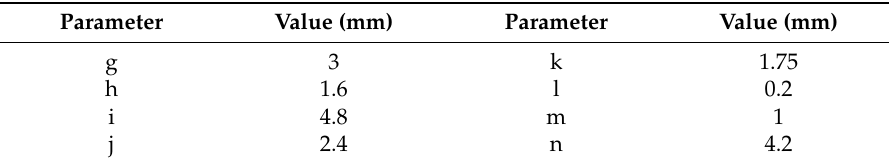
Table 2. Metamaterial unit cell parameters.